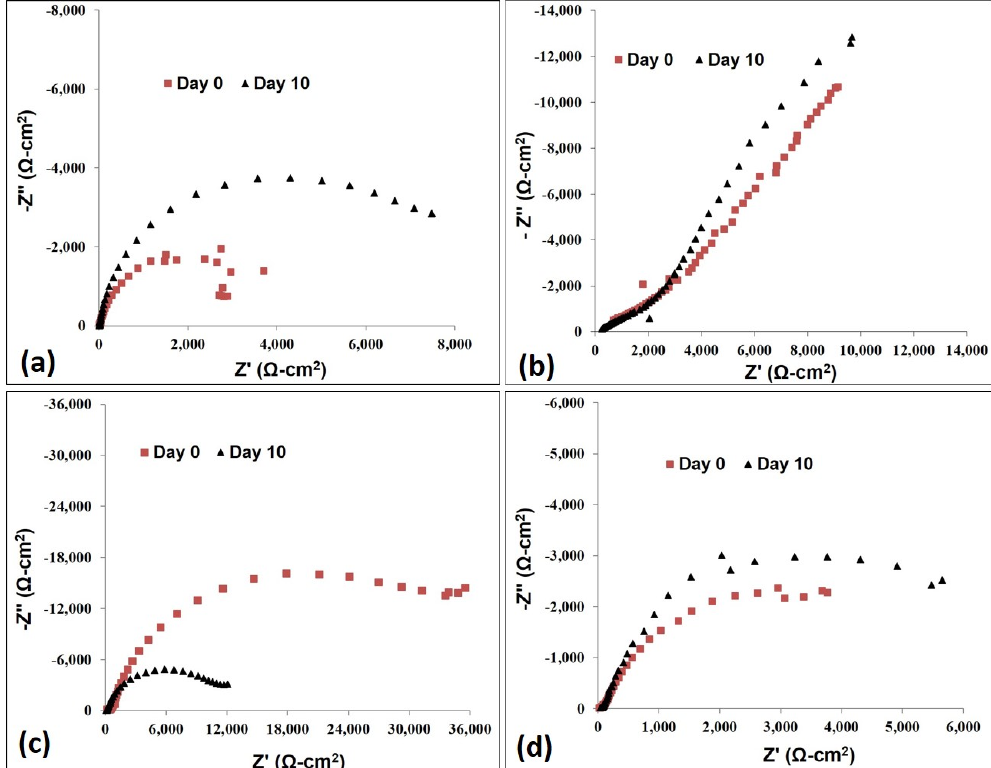
Figure 13. Nyquist plots for ( a ) Al substrate, ( b ) HA, ( c ) PEO and ( d ) PSC coatings at different immersion times.